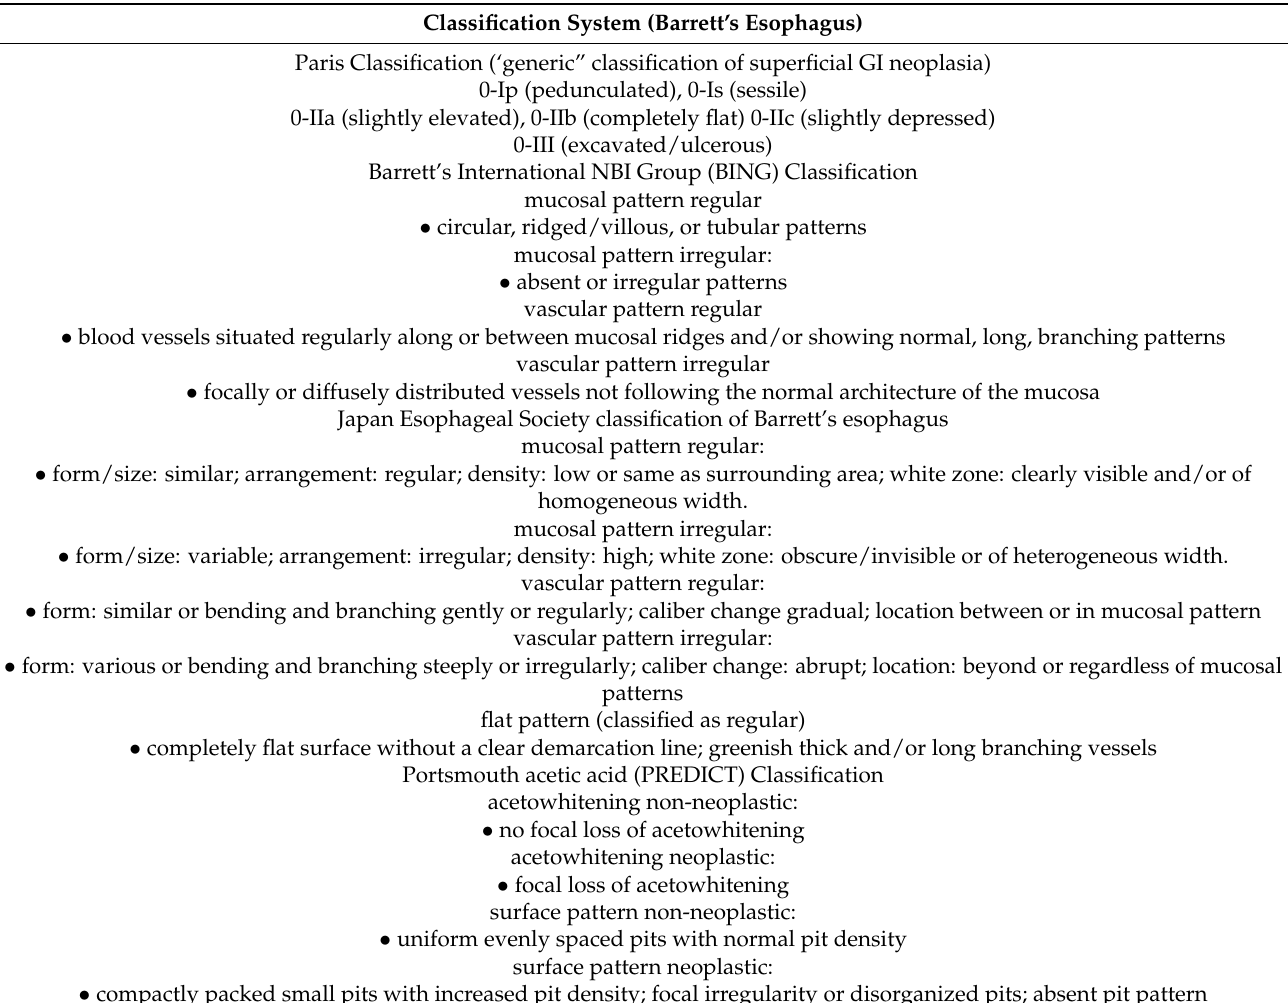
Table 1. Classification systems for Barrett’s associated neoplasia